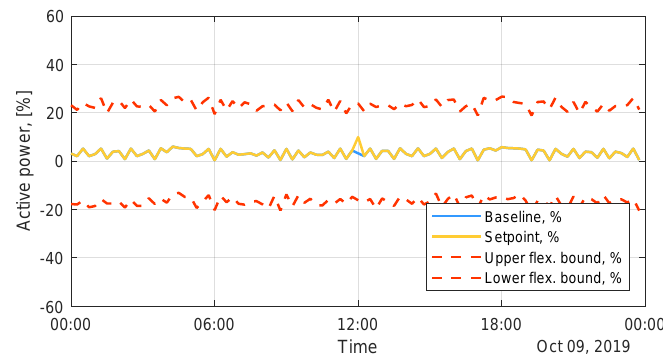
Figure 15. Control action. DSO-owned storage device connected to node 117.